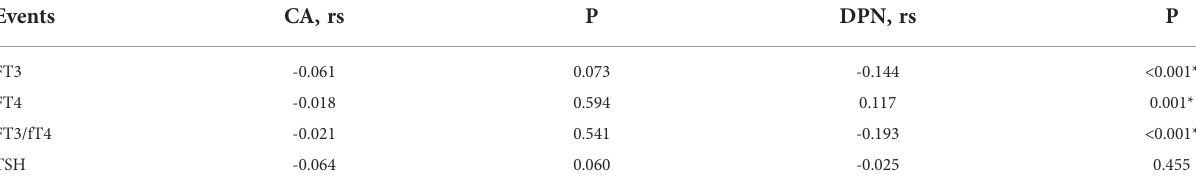
TABLE 4 Association among thyroid-stimulating hormone and vascular complications. Events